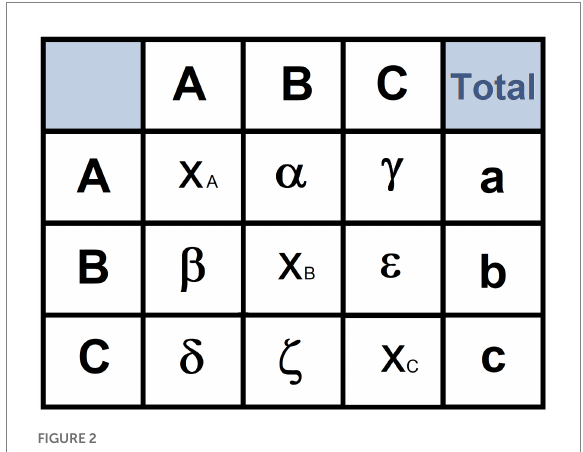
FIGURE 2 Example of transition matrix. A, B, C: names of three hypothetical behavioral units; α , number of transitions from unit A to B; γ : number of transitions from A to C; β : number of transitions from B to A; ε : number of transitions from B to C; δ : number of transitions from C to A; ζ : number of transitions from C to B; X A , X B and X C : number of auto-transitions from A to A, B to B, and C to C, respectively; a: total occurrences of A; b: total occurrences of B; c: total occurrences of C.